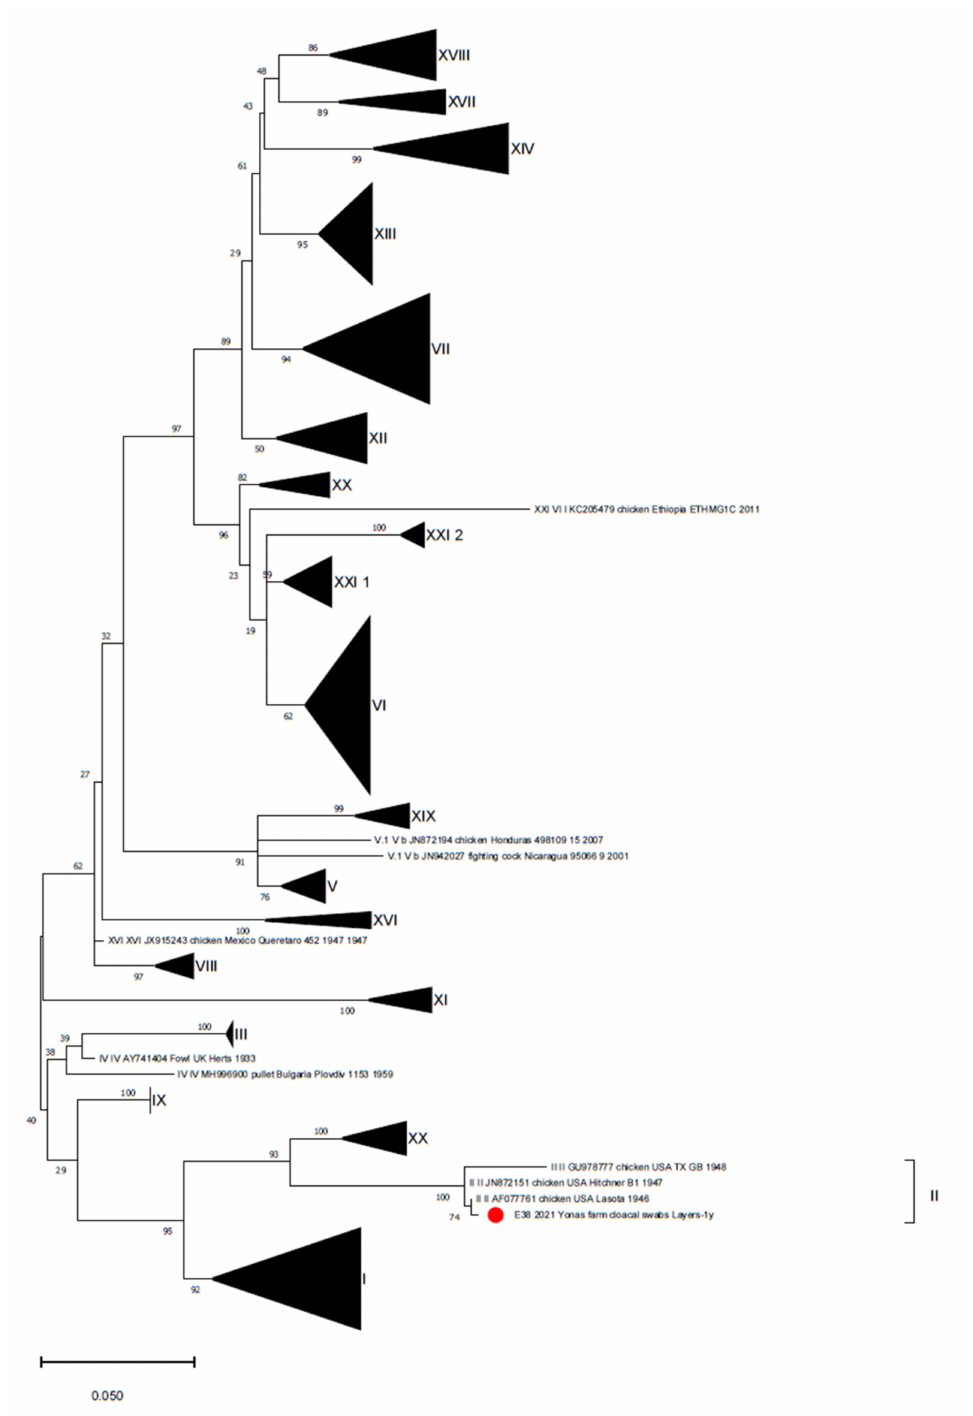
Figure 2. Phylogenetic tree reconstructed for NDV strain characterization with the database proposed by Dimitrov et al., (2019) [35]. The phylogenetic tree was reconstructed using the Maximum Likelihood method and Kimura 2-parameter model with discrete Gamma distribution. Branch support is shown next to the branches. The Ethiopian strain is marked with a red